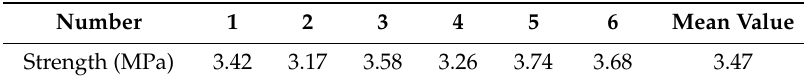
Table 7. Bond strength